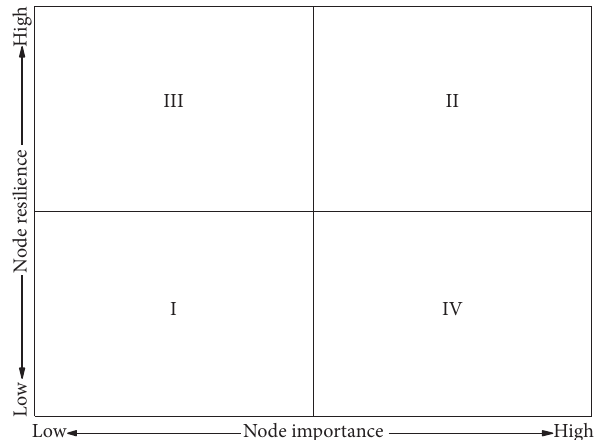
Figure 8: Matching principles of node importance and